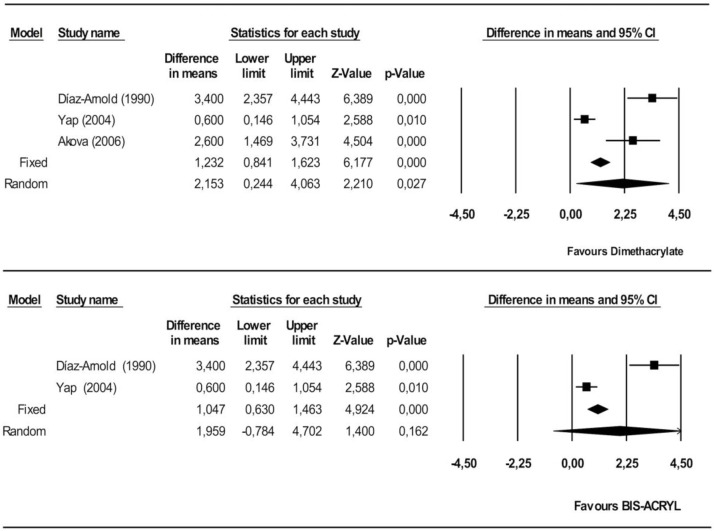
Forest plot of Knoop hardness.Dimethacrylate vs. monomethacrylate groups (Fig 5A), Bis-acryl vs. PMMA (Fig 5B).